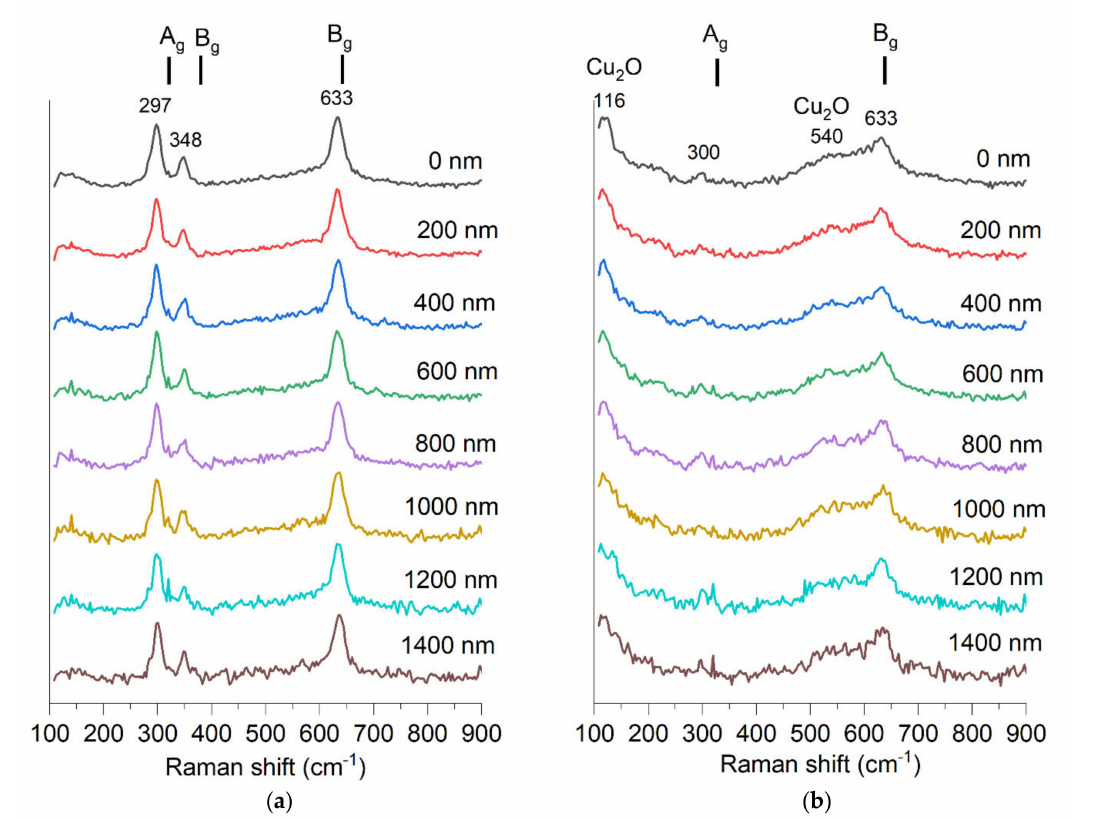
Figure 12. Raman spectra measured in depth of material with step of 200 nm of two samples ( a ) S1-G-1550 and ( b )